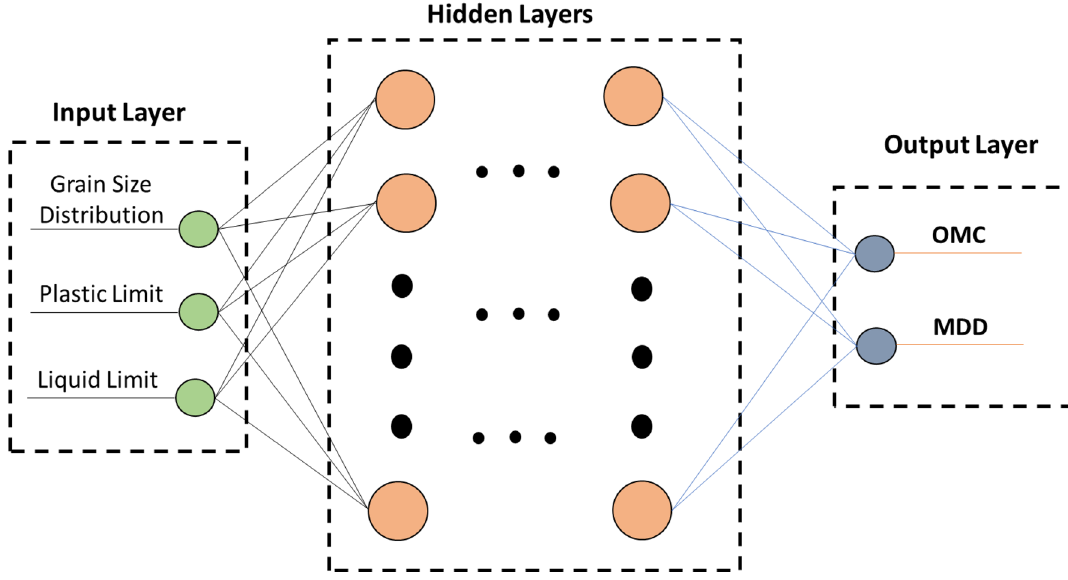
Fig. 5 The proposed general ANN structure followed in this